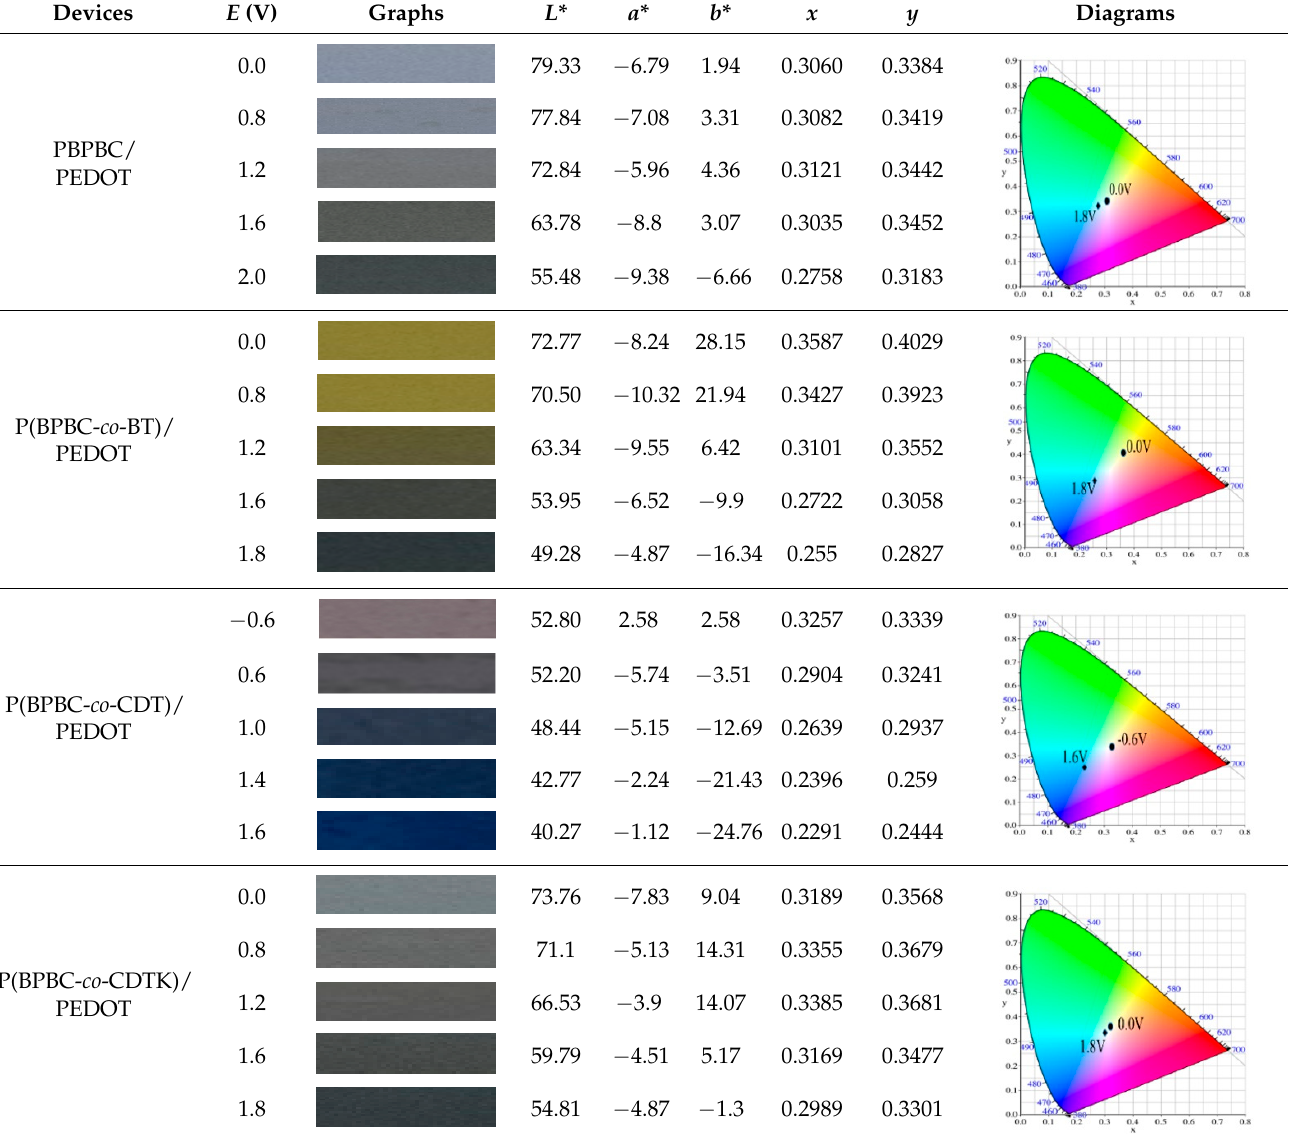
Table 5. Electrochromic photographs, colorimetric values ( L *, a *, and b *), and CIE chromaticity values ( x , y ) of PBPBC/PEDOT, P(BPBC- co -BTP)/PEDOT, P(BPBC- co -CDT)/PEDOT, and P(BPBC- co -CDTK)/PEDOT ECDs at several potentials. Devices E (V) Graphs